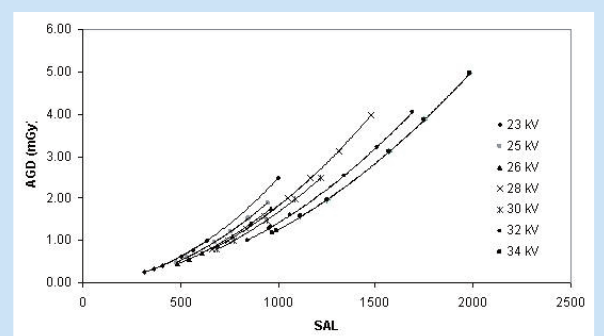
Fig. 1. AGD v. SAL on the plate at different kVp values.